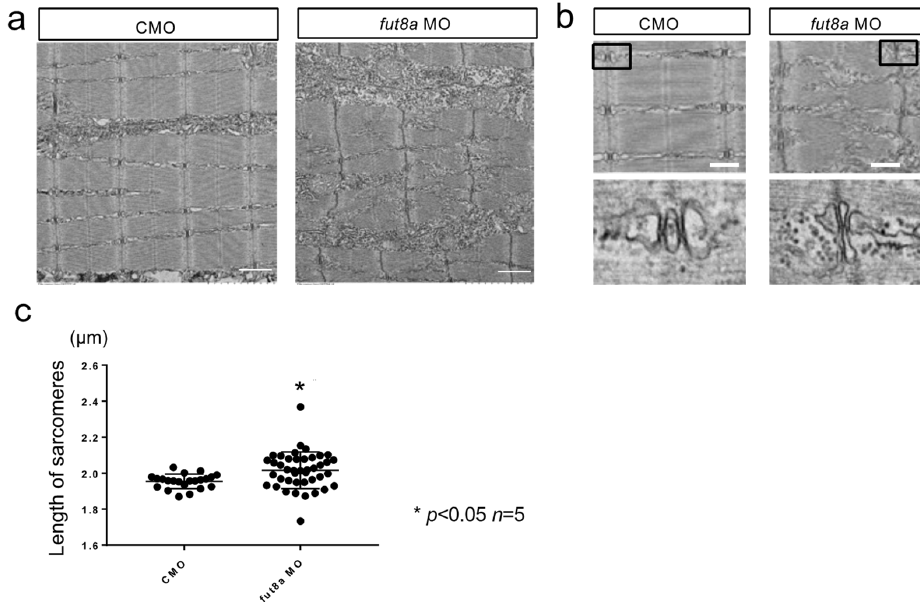
Figure 5. fut8a morphants show abnormalities in sarcomere formation ( a ) fut8a morphants displayed abnormal sarcomere structure with distorted Z-line and H-bands. Scale bar: 1 µ m. ( b ) The triad of fut8a morphants was disorganized. Black boxes show the location of lower images. Scale bar: 1 µ m. ( c ) Histogram of the variation in sarcomere length. CMO: Median 1.956, Max 2.032, Min 1.869. fut8a MO: Median 2.0325, Max 2.153, Min 1.772 ( t -test. p < 0.01, n = 5).